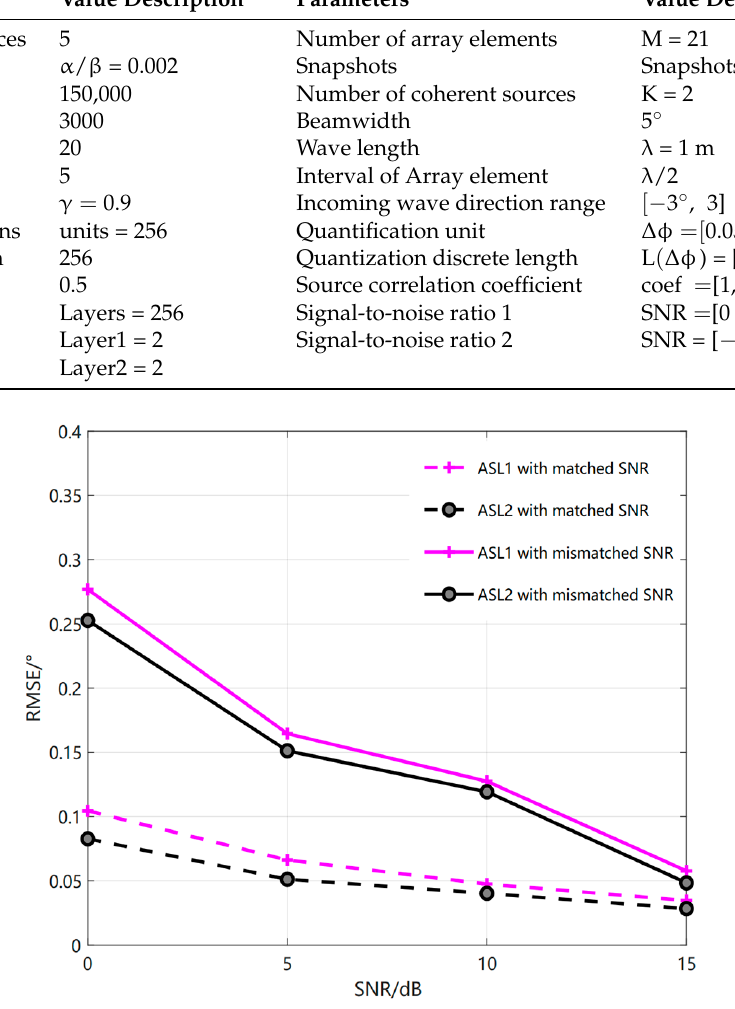
Figure 2. Relationship curve between RMSE and SNR (The real line is mismatched, and the imaginary line is matched.).